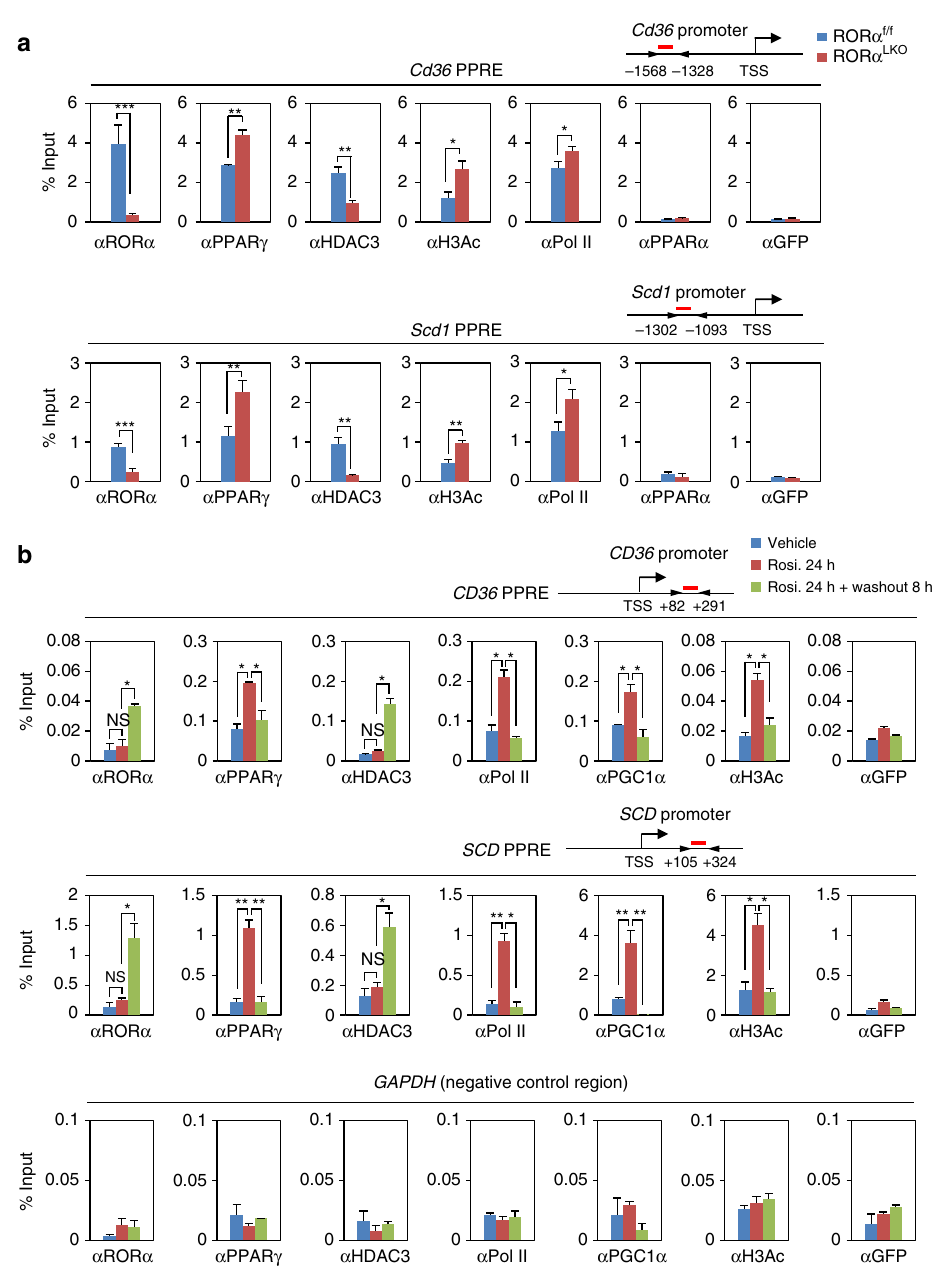
Fig. 5 ROR α recruits to the PPAR γ target gene promoters with HDAC3. a ChIP assays were performed on the Cd36 and Scd1 promoters in liver extract form ROR α f/f and ROR α LKO mice fed HFD for 10 weeks ( n = 3 per group). Promoter occupancy by ROR α , PPAR γ , HDAC3, H3Ac, Pol II, PPAR α and GFP was analyzed. Schematic of promoter region was represented with gene name. Red bar depicts locations of PPRE. Statistical analysis was performed using Student ’ s unpaired t -test. * P < 0.05, ** P < 0.01, *** P < 0.001. b ChIP assays were performed on the CD36, SCD promoters and GAPDH -negative region in Hep3B cells with or without Rosiglitazone (20 μ M) treatment for 24 h and washout 8 h. Promoter occupancy of ROR α , PPAR γ , HDAC3, Pol II, PGC1 α , H3Ac and GFP was analyzed. Schematic of promoter region was represented with gene name. Red bar depicts locations of PPRE. Statistical analysis was performed using one-way ANOVA followed by Tukey ’ s post hoc analysis. * P < 0.05, ** P < 0.01. Data expressed as mean ±